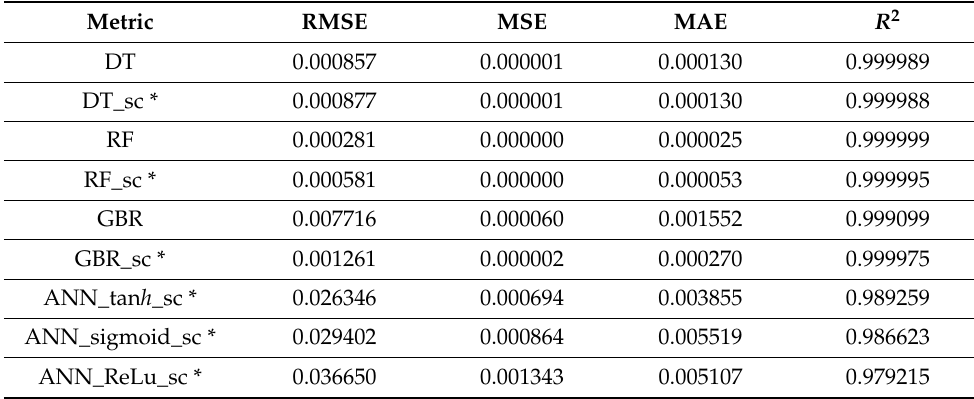
Table 9. Model performance evaluation of two phases dataset for k rwp .